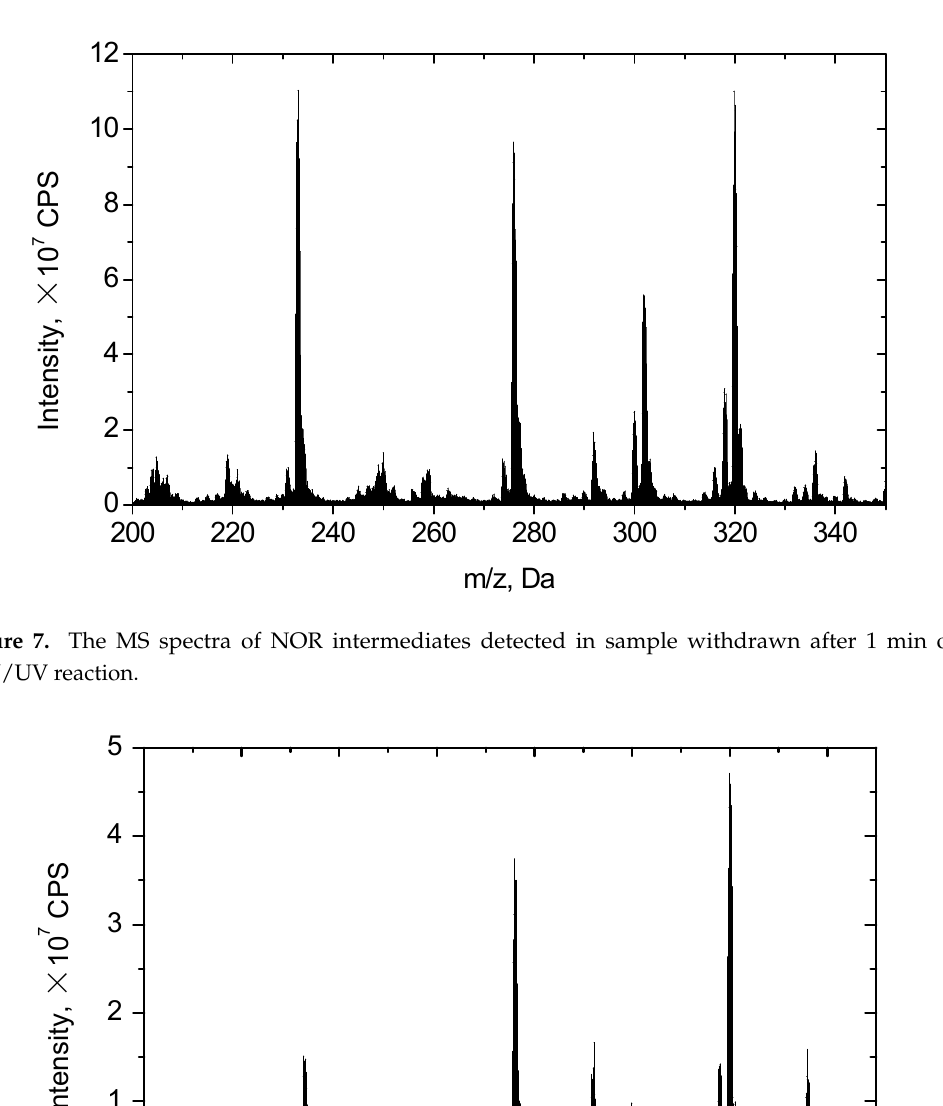
m/z, Da Figure 9. The MS spectra of NOR intermediates detected in sample withdrawn after 30 min of MW/UV reaction. Three pathways for the NOR degradation in the MW/UV process are proposed based on the identified intermediates (Scheme 1). In pathway I, ∙ OH radicals initially attack the benzene ring of NOR, which leads to the F atom substitution with ∙ OH and formation of intermediate P1. This reaction has been previously reported by Kleiser et al. [51] and Chen et al. [22]. This step was followed by a ∙ OH attack on the piperazine ring of P1, that induces the piperazine ring opening and amide formation. Then a carbon centered radical is generated on the α position amine of the piperazine side chain, and further reacts with oxygen to produce P2 under the continuous attack of ∙ OH. Further attacks of ∙ OH on P2 subsequently form P3 and P7.